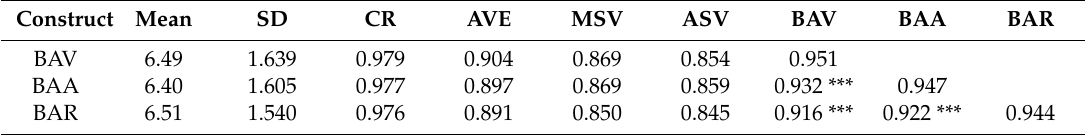
Table 6. Correlation and discriminant validity of the Buddhist aesthetics